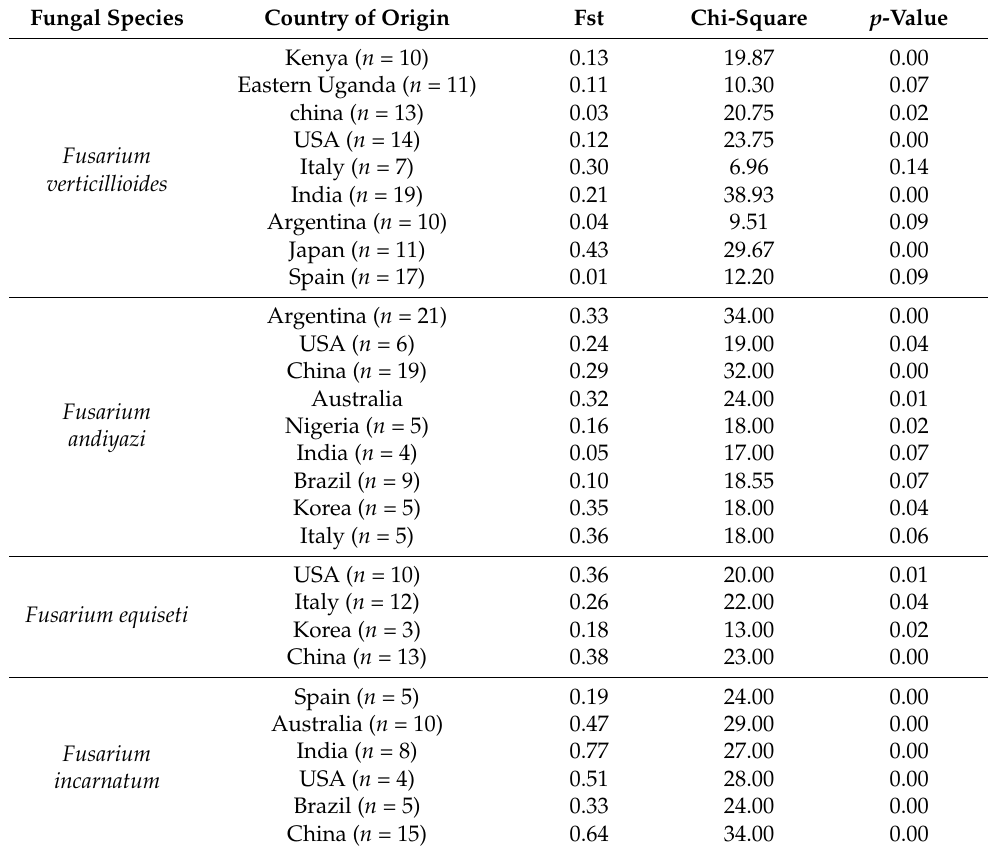
Table 3. Genetic differentiation between isolates of Fusarium species isolated from Uganda and isolates reported in other countries using partial TEF1- α